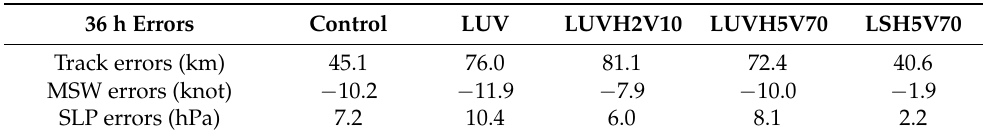
Table 2. Mean 36 h forecast errors from lidar wind speed and wind component data assimila- tion experiments.